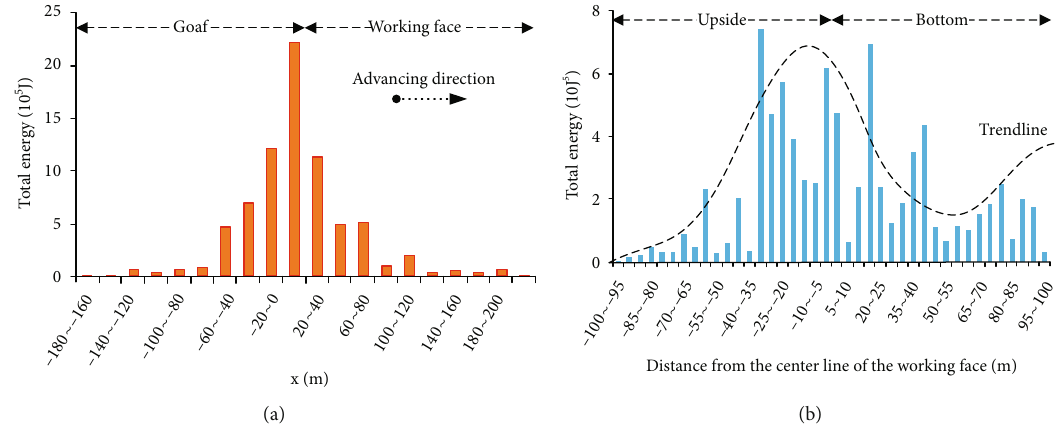
Figure 15: Characteristics of microseismic energy evolution during mining at LW7313: (a) microseismic energy distribution on the working face strike; (b) microseismic energy distribution on the working face